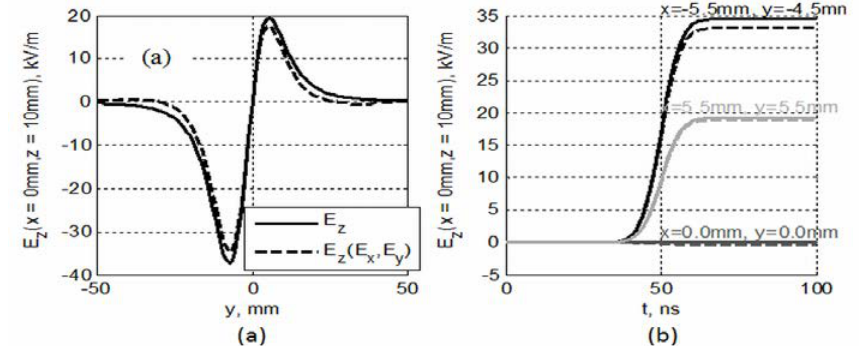
Figure 20: Comparison between directly computed and extracted E z field: (a) at the instant time t = 50 ns along the line z = 10 mm, x = 0; (b) as a function of time at the points ( x , y ) = {(0,0), (-5.5mm,-4.5mm), (5.5mm,4.5mm)} on the horizontal plane at z = 10mm.